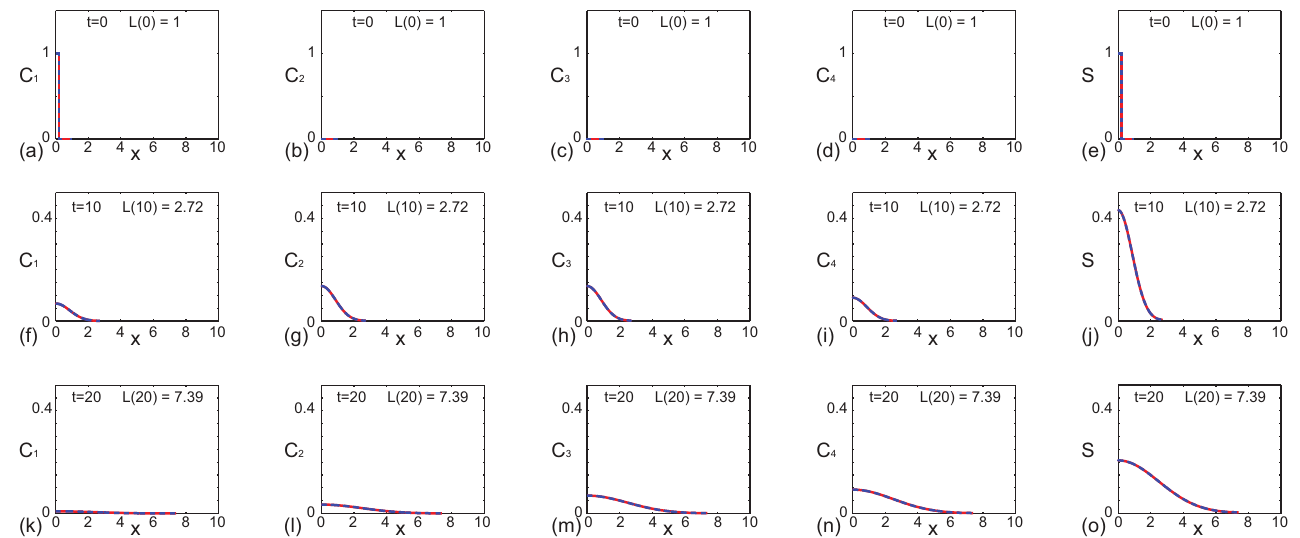
Fig 4. Comparison of exact and numerical solutions of Eqs (12) – (15) with equal reaction rates. Profiles in (a) – (e), (f) – (j) and (k) – (o) show C 1 ( x , t ), C 2 ( x , x , t ), C x , t ) and S ( x , t ) at t = 0,10, and 20, respectively. Each subfigure shows the exact solution (solid red) superimposed on the numerical solution t ), C 3 ( 4 ( (dashed blue). This example corresponds to exponential domain growth with L (0) = 1, L (10) = e (cid:5) 2.78 and L (20) = e 2 (cid:5) 7.39, as indicated in each subfigure. The exact solutions are obtained by truncating the infinite series after 1000 terms and the numerical solutions (S1 Supporting Information) correspond to δξ = δ t = 1 × 10 − 3 . Here we have L (0) = 1, α = 0.1, C = 1, γ = 0.2, D = 1 × 10 − 2 , k